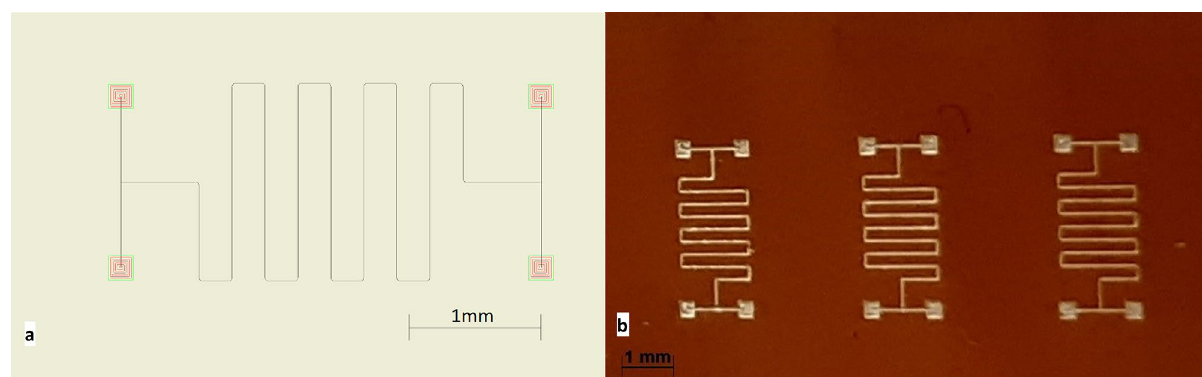
Figure 4. Pattern for four-point resistivity test ( a ) pattern design; ( b ) patterns printed on Kapton film and IR